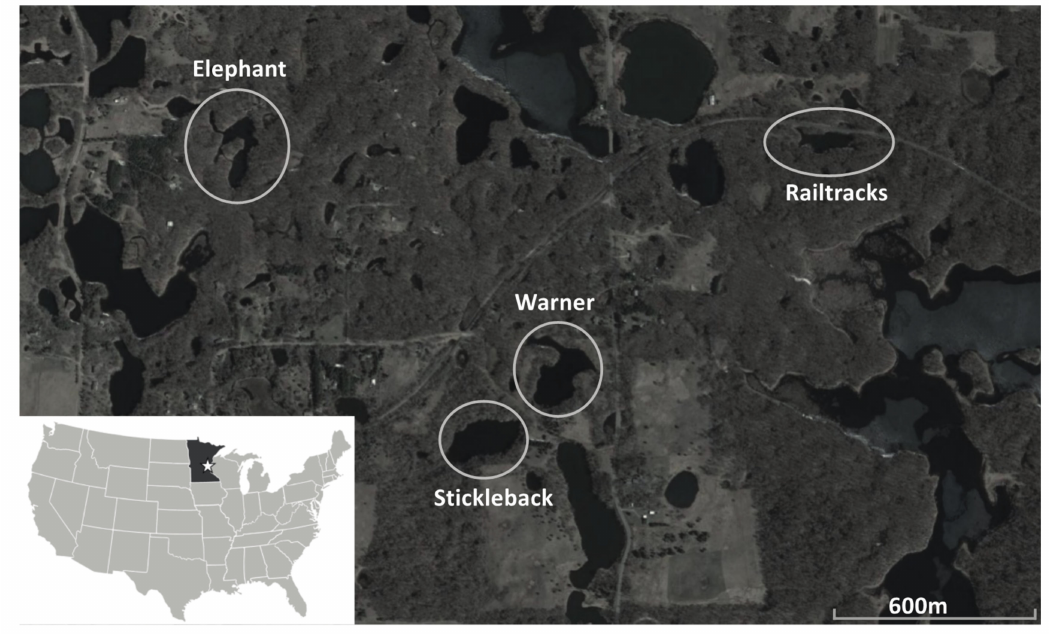
Figure 1. Location of study ponds in east-central Minnesota,